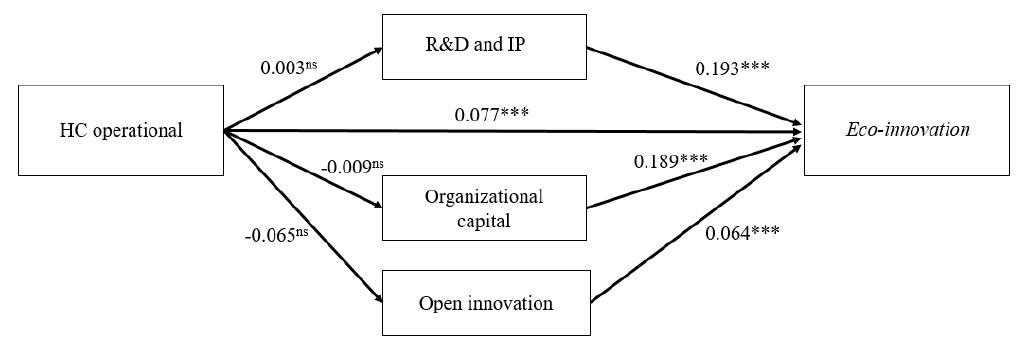
Figure 2: Effects of HC Operational and Other Intangible Assets on Eco-